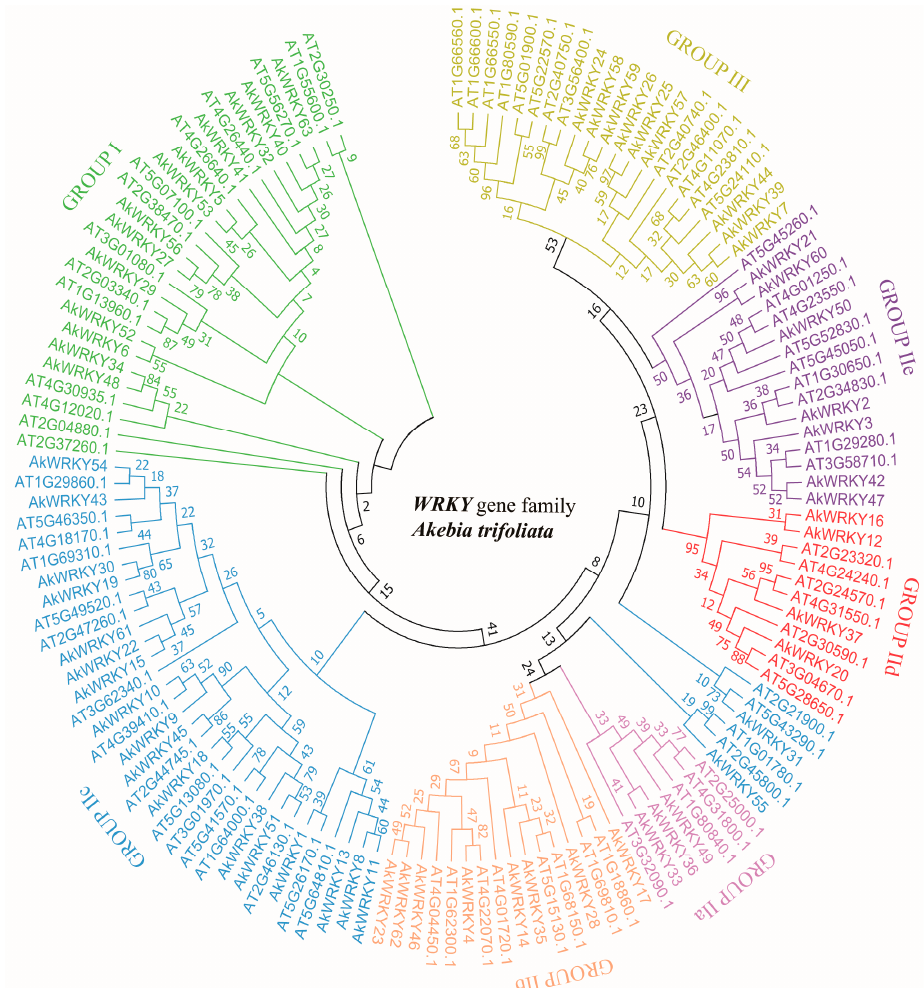
Figure 3. A rootless phylogenetic tree established based on the amino acid sequences of Arabidopsis and A. trifoliata . The tree divides AkWRKY proteins into seven subgroups, which are distinguished by different colors. Bootstrap confidence values from 1000 replicates are indicated at each branch. Table 1. Groups of WRKY genes in the A. trifoliata genome.